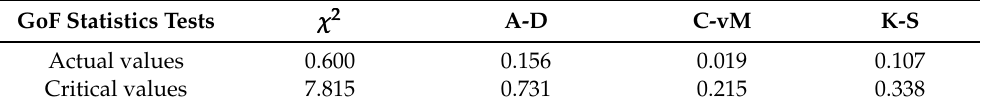
Table 7. Goodness-of-fit statistics tests results for the specimens of 12 mm in diameter.